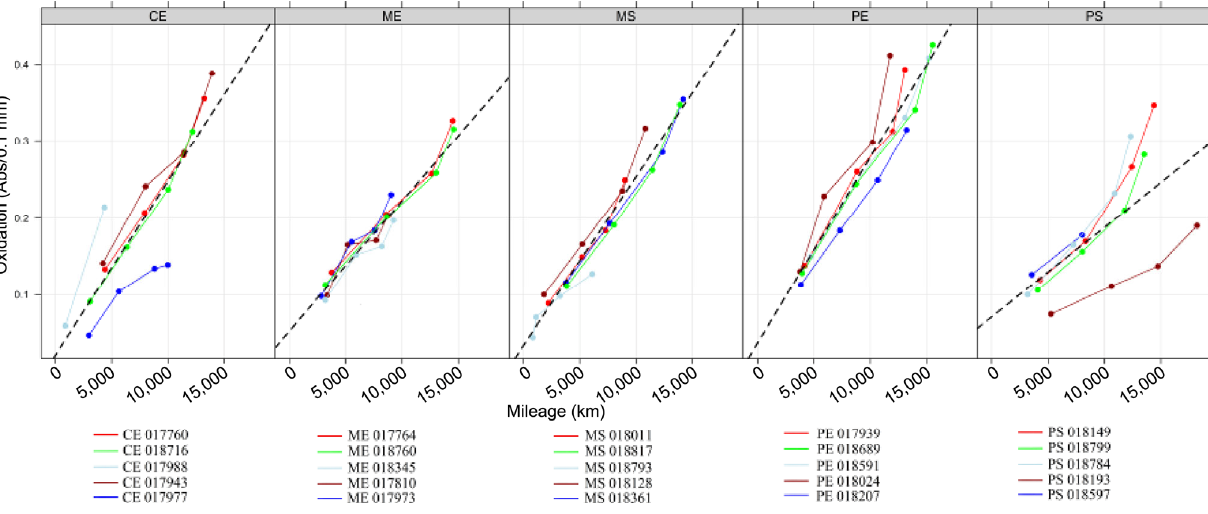
Fig. 2 Changes in engine oil oxidation